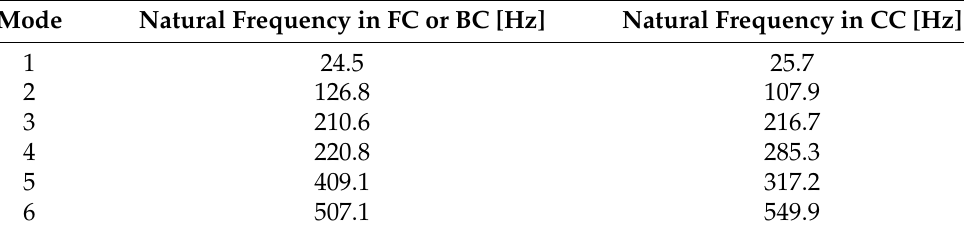
Table 6. Natural frequencies of the Y-rail with the cutting head in different positions.